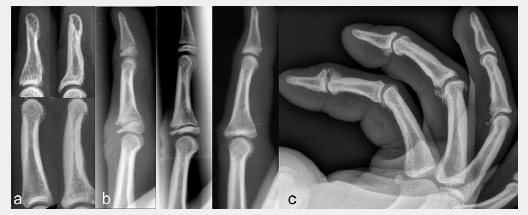
Osseous adaptations of climber’s distal and middle phalanx compared with a non-climbers bones (A); epiphyseal thinning (B, left), epiphyseal fracture (B, middle) in an adolescent climber, strict avoidance of crimp grip let the fracture heal without a joint surface incongruity or axial deviation (B, right); lateral view of the fingers of a 38-year-old world class boulderer, almost every joint shows osteophytes and calcifications of the capsule, joint space narrowing, a main sign of osteoarthritis however is not